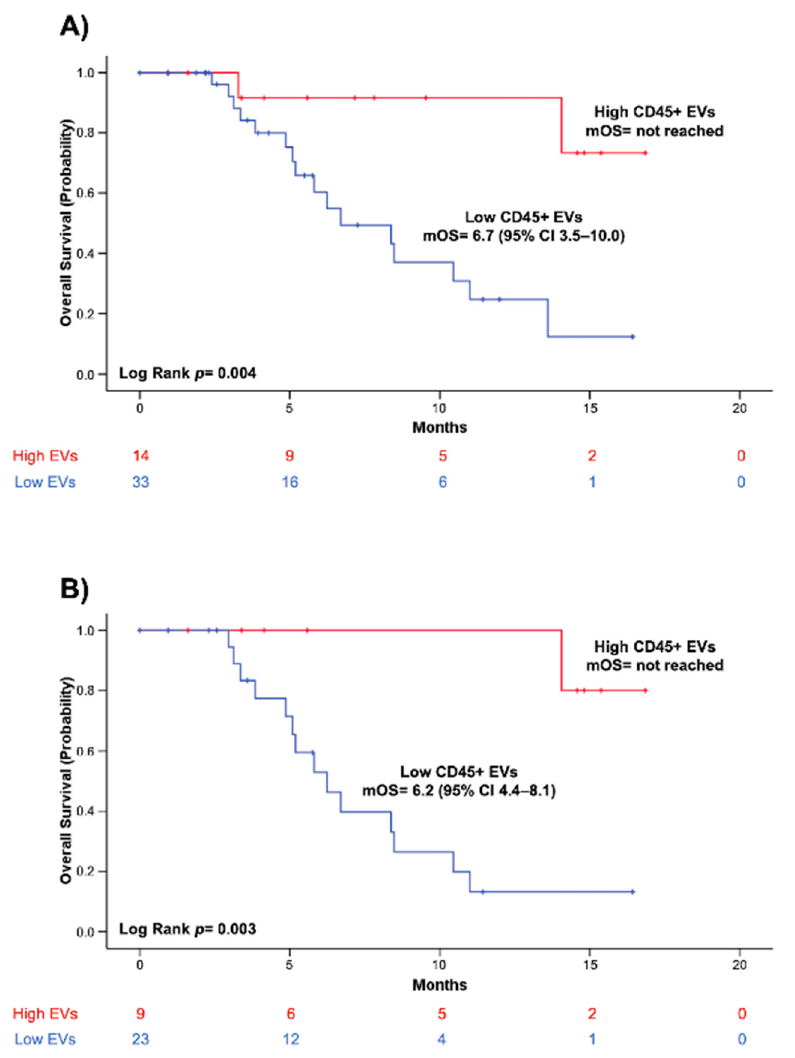
Figure 2. Kaplan–Meier (KM) curves showing the relationship between overall survival and blood concentration at baseline of leukocyte-derived EVs (CD45+) in the cohort of patients with borderline resectable, locally advanced, or metastatic PC ( A ) and in the subgroup of patients with locally advanced or metastatic PC ( B ). Log-rank test was used to statistically compare KM survival curves. 3.5. Increased Blood Levels of Circulating CD45+ EVs Are Associated with Higher Disease Control Rate and Longer Progression-Free Survival in Patients with Advanced PC To investigate whether blood EV concentrations at baseline correlated with treatment response, we analyzed progression-free survival and disease control rate in patients with locally advanced or metastatic PC ( n = 32). Data for PFS analysis were available in 30 of 32 patients. Median PFS was 5.7 months (95% CI 4.0–7.5). Radiological assessment of treatment response was available in 20 of 32 patients. The overall DCR was 65%. Univariate and multivariable Cox proportional hazards regression analyses were used to explore the correlation between PFS and pre-treatment blood levels of total EVs and EV subpopulations. EV concentrations were dichotomized using the same cut-off values employed for OS analysis. On univariate analysis, blood concentrations of total EVs ( p = 0.03), CD45+ ( p = 0.01), PD-L1+ ( p = 0.02), and PD-L1+CD45-( p = 0.02) EVs were significantly associated with PFS (Supplementary Table S3). Univariate analysis was also performed to study the association between PFS and patients’ characteristics, including